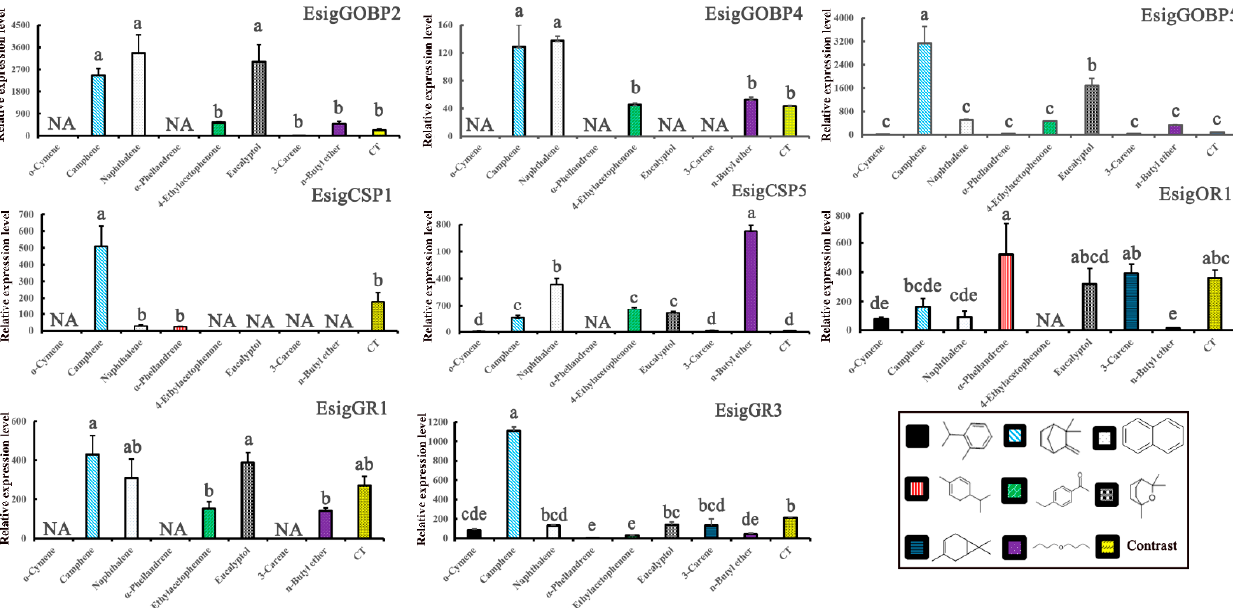
Figure 4. Expression profile (mean + SE) of E. signifer larvae after exposure to volatiles. NA: no expression. Different lowercase letters above the bars denote significant differences at p < 0.05.